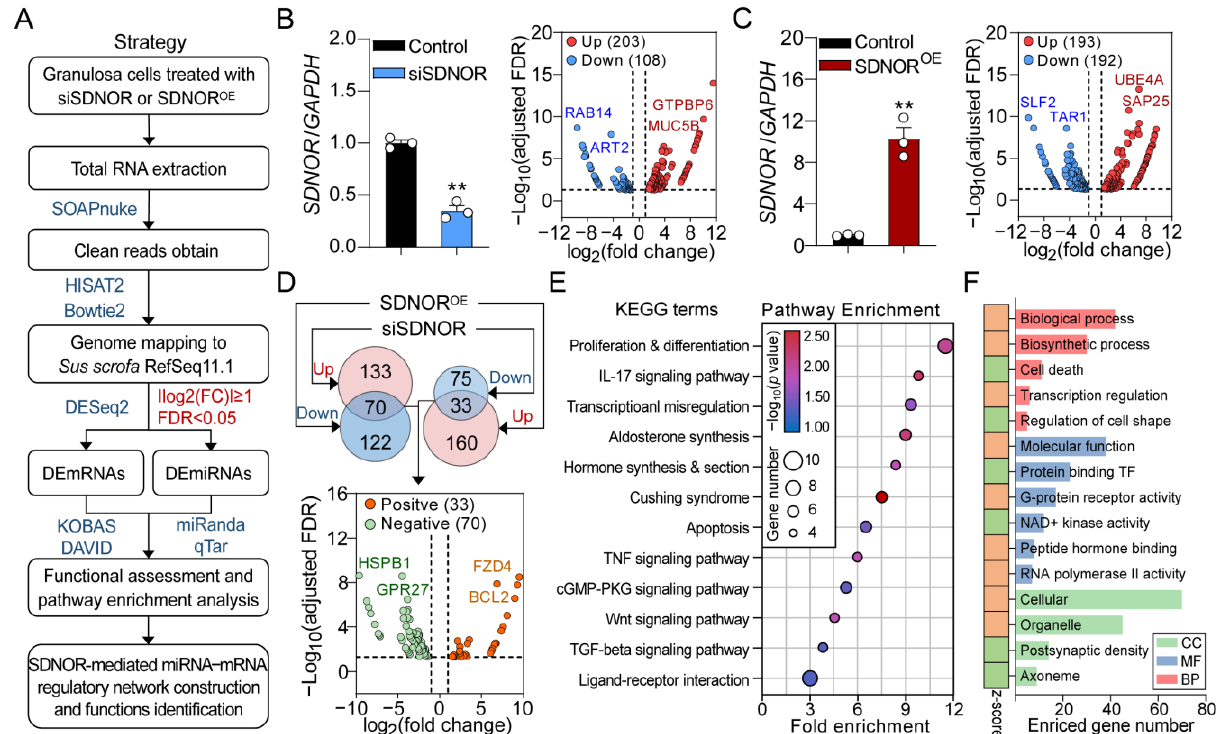
Figure 1. Identification and functional analyses of the SDNOR-mediated DEmRNAs. ( A ) Flow diagram showing the strategy for identification and functional assessment of the DEmRNAs and DEmiRNAs. ( B ) Left panel: the expression level of SDNOR in porcine GCs treated with siSDNOR was detected by RT-qPCR assay ( n = 3). Right panel: volcano plot representing the expression alternation of DEmRNAs induced by SDNOR inhibition. Red and blue dots indicate up- and downregulated genes, respectively. ( C ) The expression pattern of DEmRNAs in porcine GCs after overexpression of SDNOR (left) was analyzed and is shown in the volcano plot (right). ( D ) Identification and alternation analysis of the SDNOR-regulated DEmRNAs. ( E ) KEGG analyses of the SDNOR-regulated DEmRNAs and 12 significant enriched terms ( p < 0.05) are listed. ( F ) GO analyses of SDNOR-mediated DEmRNAs. The columns in green, blue, and red indicate the enriched terms of cell component (CC), molecular function (MF), and biological process (BP) categories. Z scores were calculated to estimate the alteration trend of the significantly enriched GO terms ( p < 0.05), which are shown as squares labeled in orange (upregulated) and green (downregulated). Data in B , C are shown as mean ± S.E.M. with three independent replicates, and the significance was analyzed with a two-tailed Student’s t -test. ** p < 0.01.